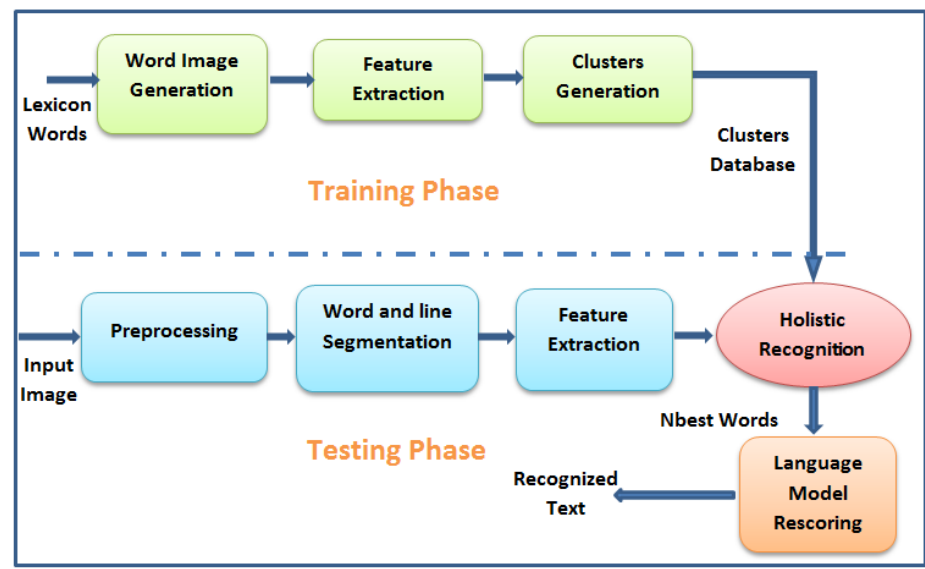
Figure 2. Block Diagram of the Holistic OCR